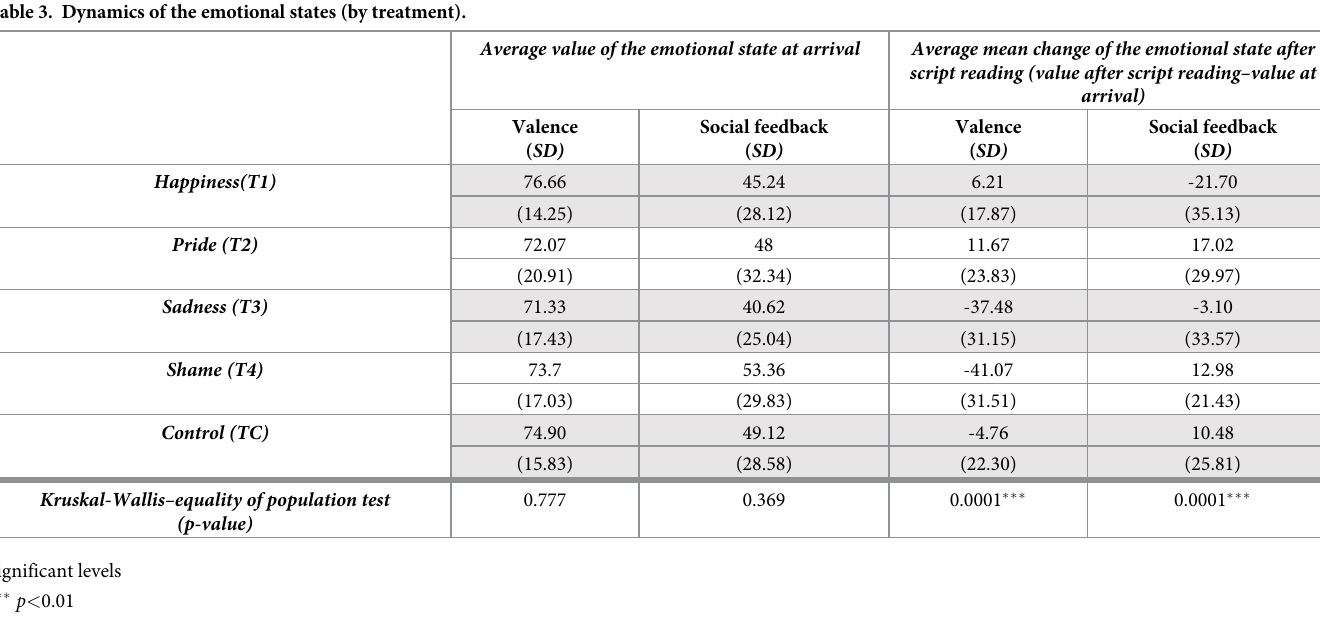
Table 3. Dynamics of the emotional states (by treatment).